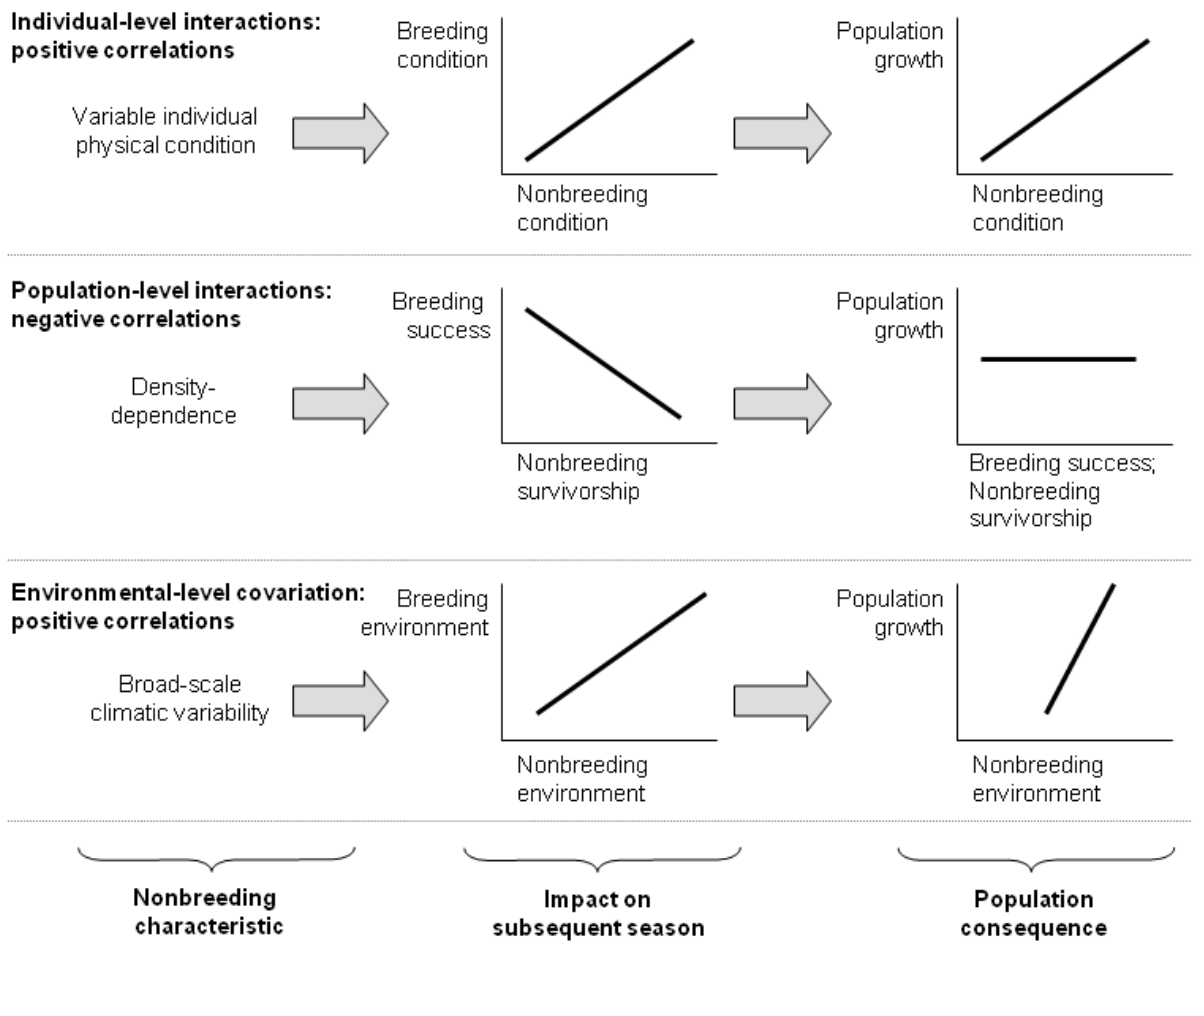
covariation among seasonal environments and thus among consecutive seasonal vital rates, with the potential for magnified climatic impacts on population growth. See Table 2 and text for further details and literature